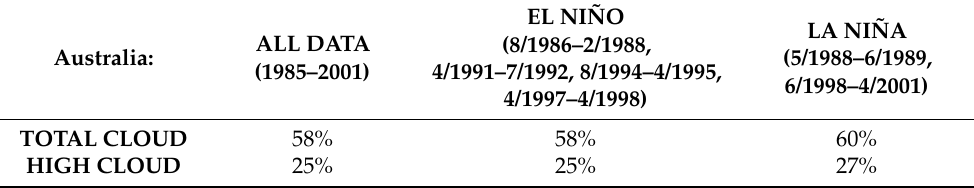
Table 3. The Australian region (10 ◦ S–45 ◦ S, 105 ◦ E–160 ◦ E) cloud frequency observations of total cloud and high cloud (CTP < 440 hPa) over land. Observations from La Niña and El Niño years are summarised and compared with the cloud frequency percentages taken from the full HIRS data set (1985 through to